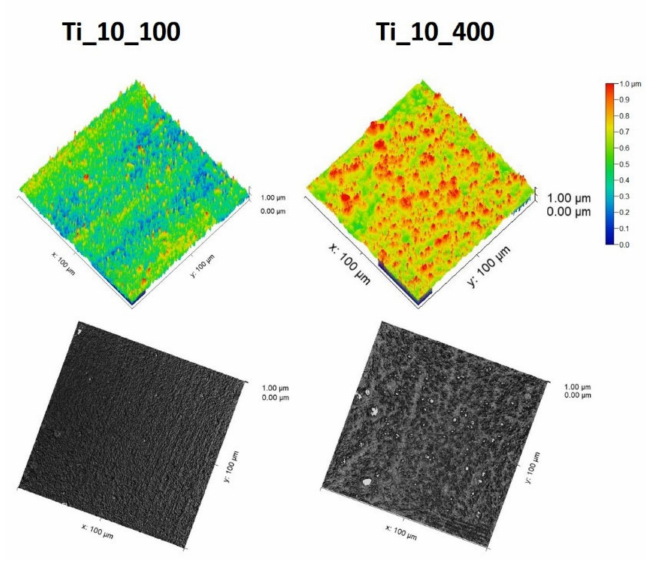
Figure 4. Confocal microscopy images of coating